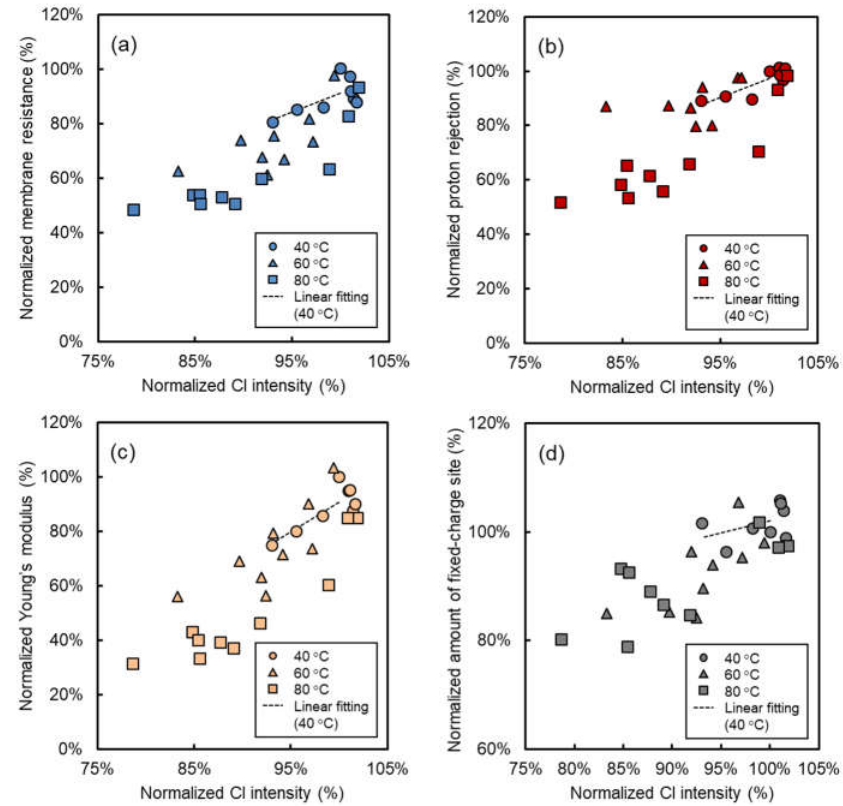
Figure A2. Correlation between normalized electrical and mechanical performance and normalized Cl intensity after NaOH immersion at 40 °C, 60 °C and 80 °C: normalized ( a ) electrical resistance, ( b ) proton rejection, ( c ) Young’s modulus, and ( d ) amount of fixed-charge sites.